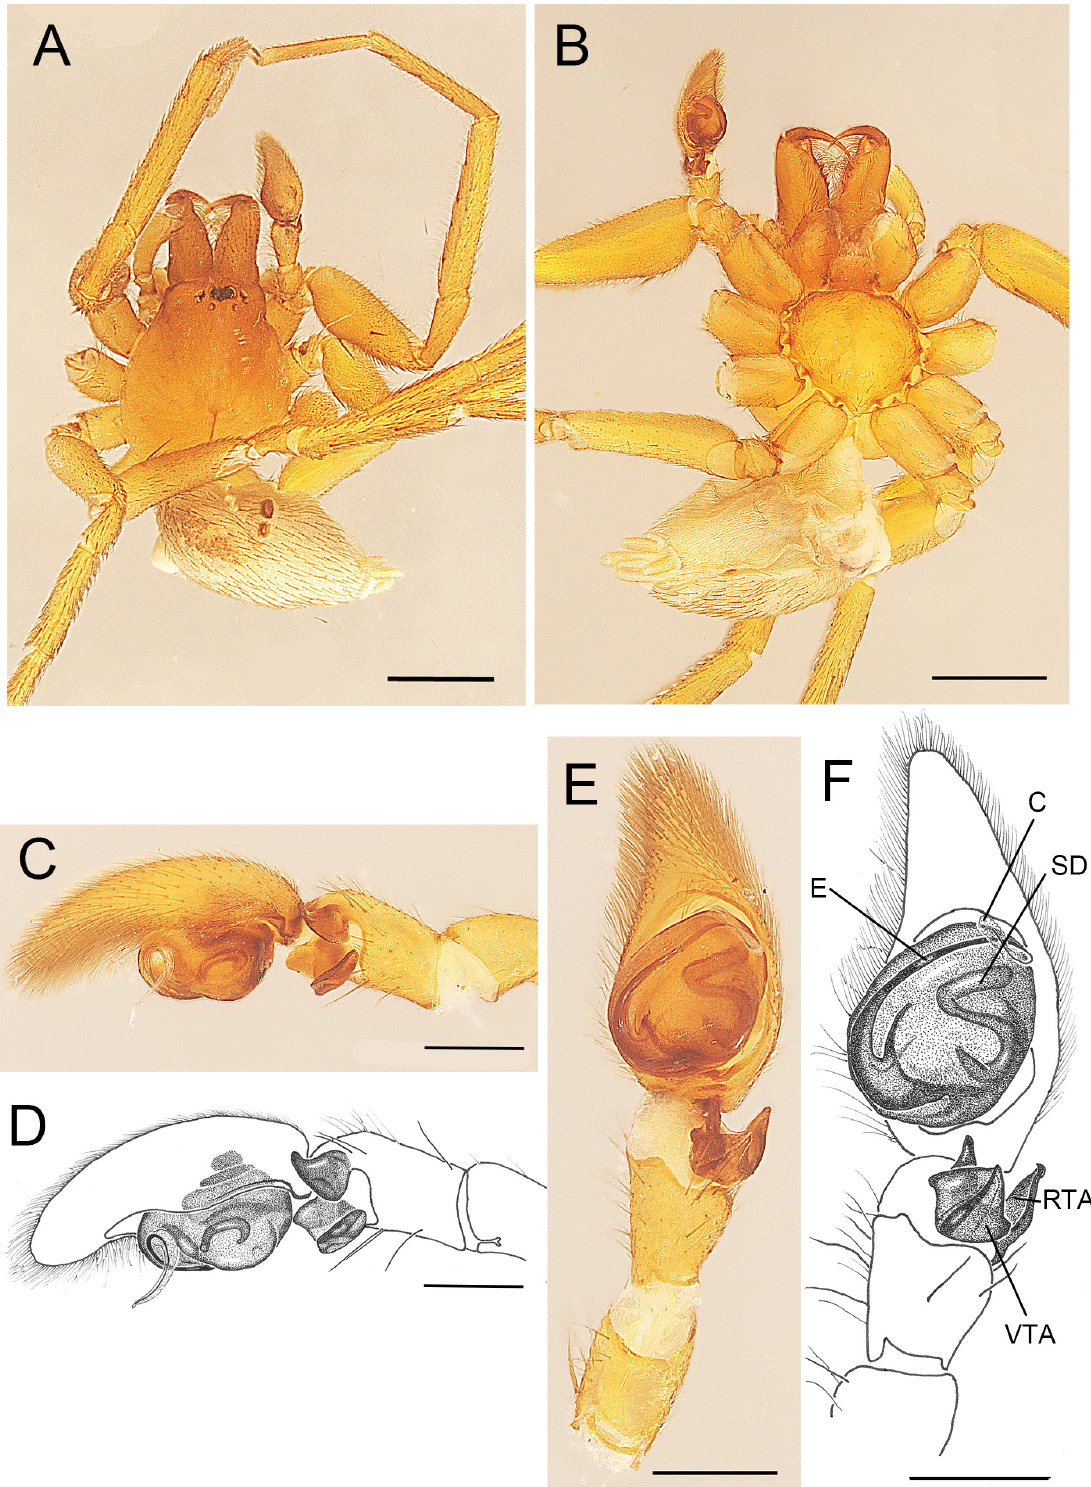
Fig. 21. Andromma divinagraciae sp. nov., ♂, holotype (BE_RMCA_ARA.Ara 246051). A . Habitus, dorsal view. B . Same, ventral view. C–D . ♂, left palp, retrolateral view. E–F . Same, ventral view. Abbreviations: C = conductor; E = embolus; RTA = retrolateral tibial apophysis; SD = sperm duct; VTA = ventral tibial apophysis. Scale bars: A–B = 1 mm; C–F = 0.2